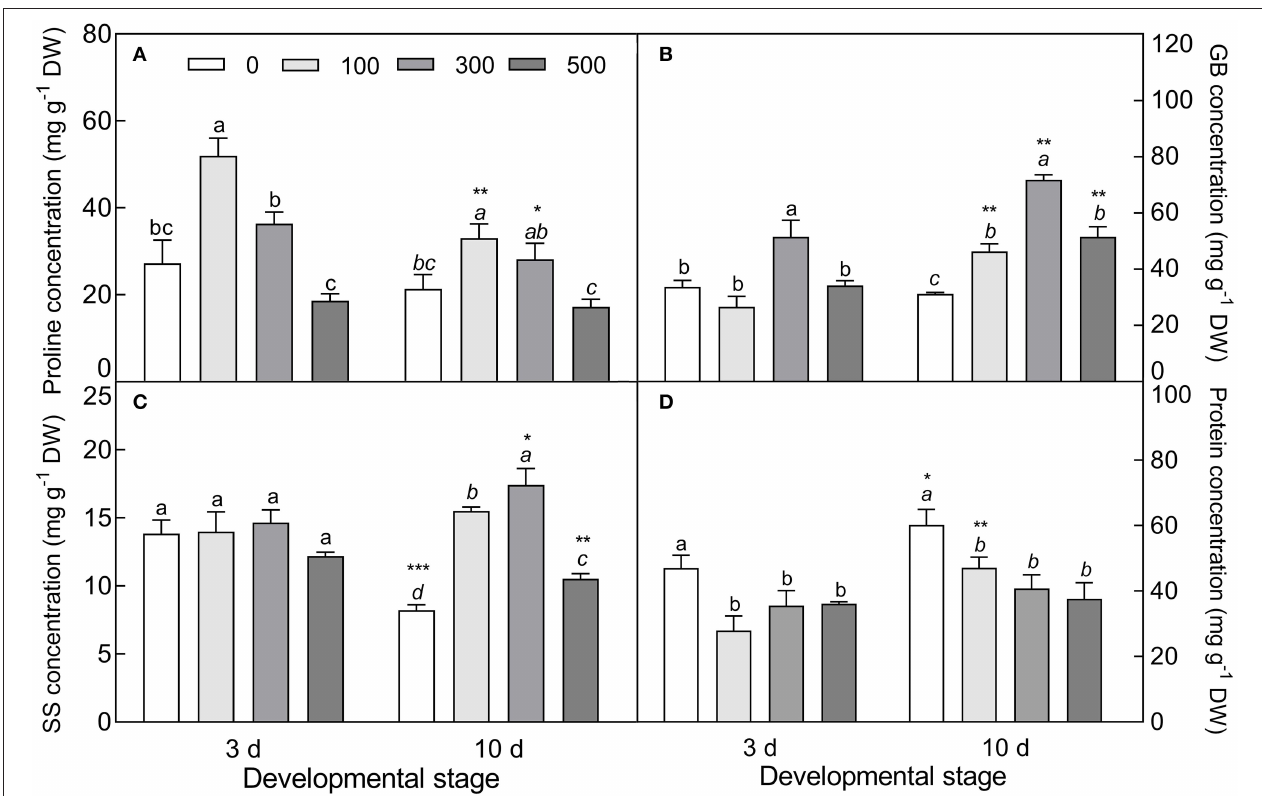
FIGURE 10 | Changes in the concentration of osmotic protectants during seedling development under salt stress. (A) Proline, (B) glycinbetaine (GB), (C) soluble sugar (SS), and (D) total soluble protein. 3 d and 10 d represent 3 and 10 days after seedling emergence, respectively. 0, 100, 300, and 500: different NaCl concentrations (mM). Bars with different lowercase letters of the same developmental stage indicate significant differences ( P < 0.05) at different salt concentrations; *, **, and *** indicate a significant difference between 3 d and 10 d at the same salt concentration at the 0.05, 0.01, and 0.001 levels, respectively. Values are means ± SE of three